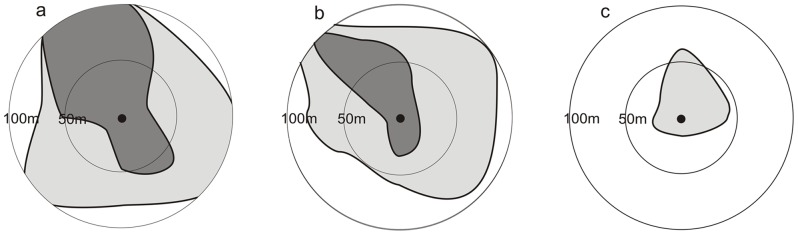
Physical disturbance at Morvin.Representation of the visible horizontal extent of drilling disturbance at Morvin: a) Post 1, b) Post 2, c) Post 3. The filled black circles in the centre represent well position, dark grey = complete coverage of sea bed with drill cuttings; light grey = partial coverage.